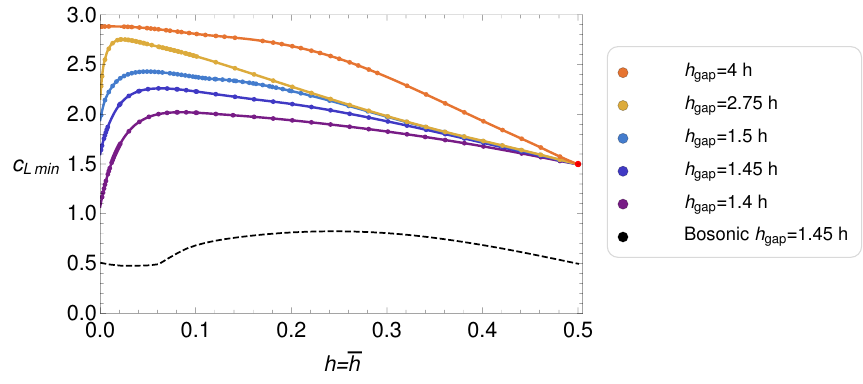
Figure 2 . Lower bound on the allowed left central charge c L (supersymmetric side) of N = (2 ; 0) SCFTs as a function of the external dimension, h = (cid:22) h , after imposing di(cid:11)erent gaps on the spectrum of superprimary scalar operators h gap = (cid:22) h gap . The lines with dots correspond to the full set of crossing equations. The dashed black line corresponds to the bound obtained from the crossing equations of the superconformal primary alone, which matches with the bosonic bootstrap bounds, and is shown for a single value of h gap . The red dot marks the central charge and external dimension of the known (2 ; 2) and (2 ; 0) minimal models discussed below eq. (3.3) which have identical four- point functions for this external operator. The bounds were obtained for (cid:3) = 20, and the rate of convergence of the numerical bounds is shown in (cid:12)gure 3 for h = (cid:22) h = 0 : 5.